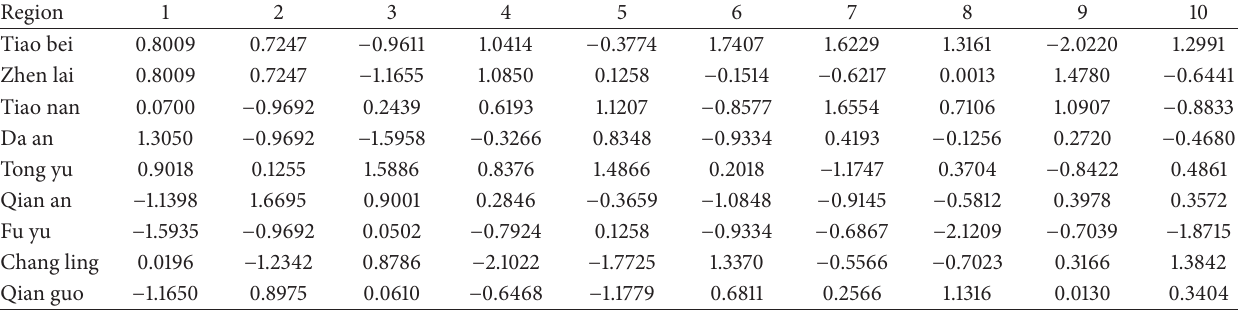
Table 2: Standardized